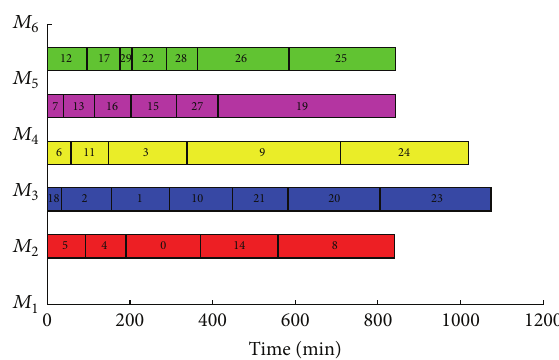
on cutting-stock problem and the combined cutting-stock and lot-sizing problem, but the study of the cutting schedul- ing problem has been ignored. To the best of our